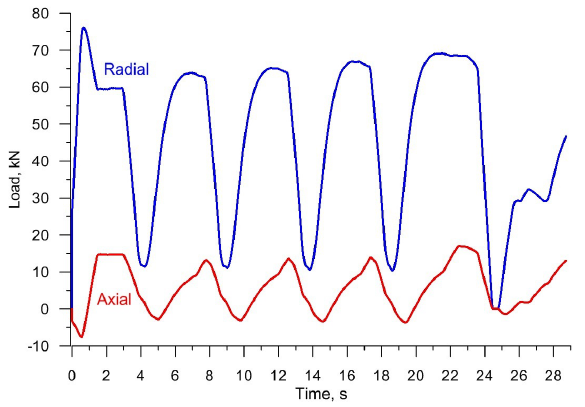
Figure 9: Variations in the axial and radial loads acting on the roll in the skew rolling process for a crankshaft preform